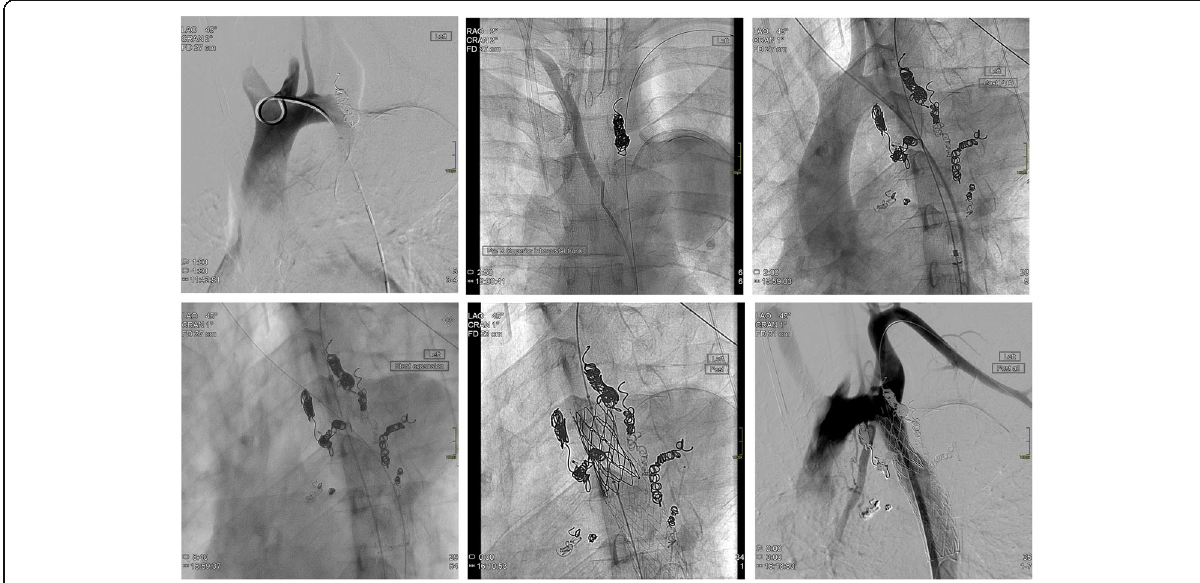
Fig. 3 Sequential embolization of collaterals followed by insertion of self-expanding and then balloon mounted stent grafts. Successful embolization and stent-grafting with no